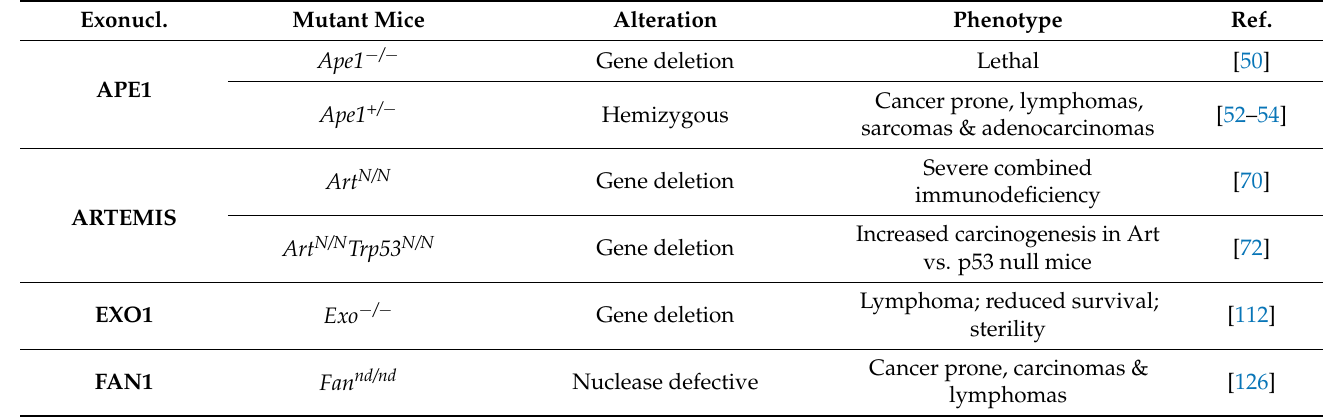
Table 2. Murine strains modelling exonuclease gene functions.